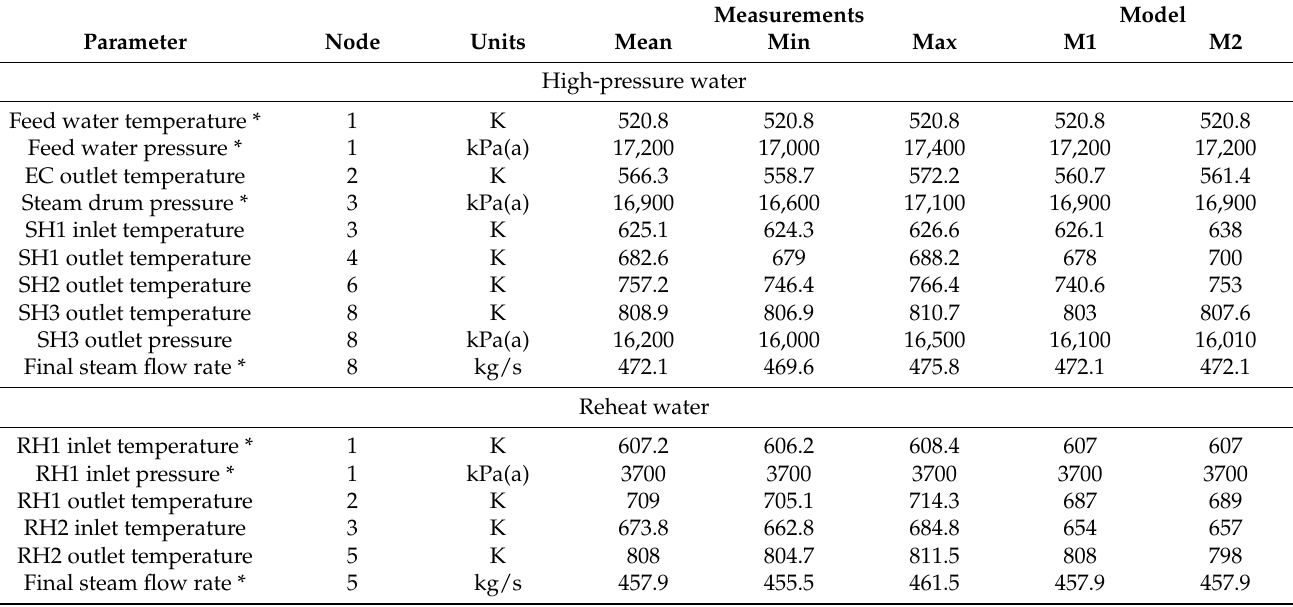
Table 4. Comparison between measured and calculated water/steam values for utility-scale coal-fired boiler model for 100% MCR load